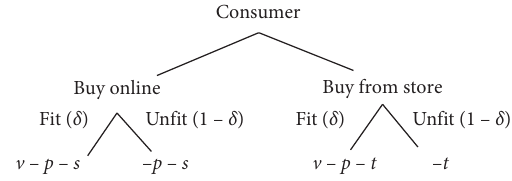
Figure 1: Consumers’ decision tree and utility in benchmark.